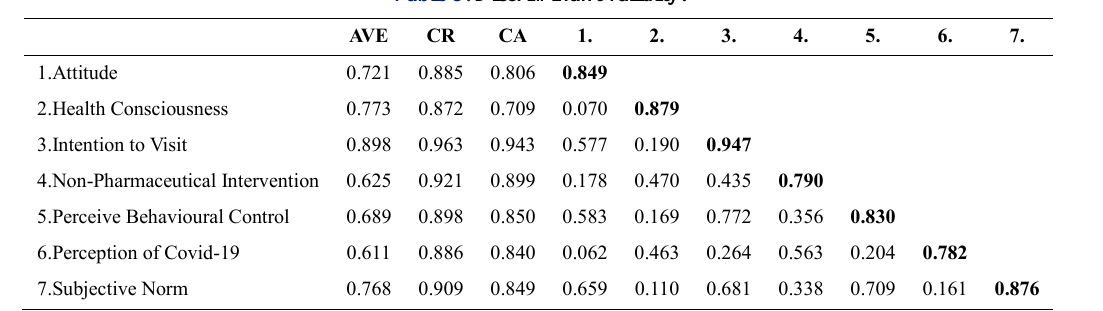
Table 3. Discriminant validity.